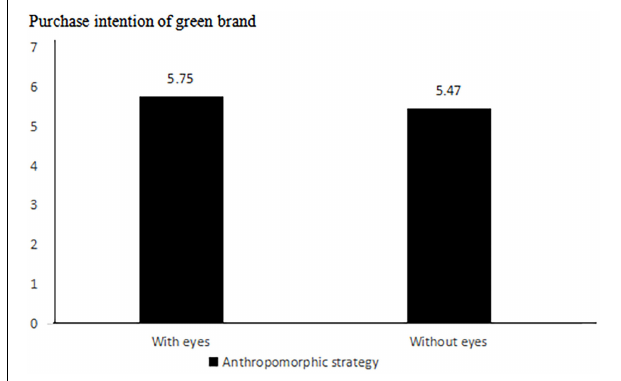
FIGURE 4 | Impact of anthropomorphic strategies on green brand purchase intention.